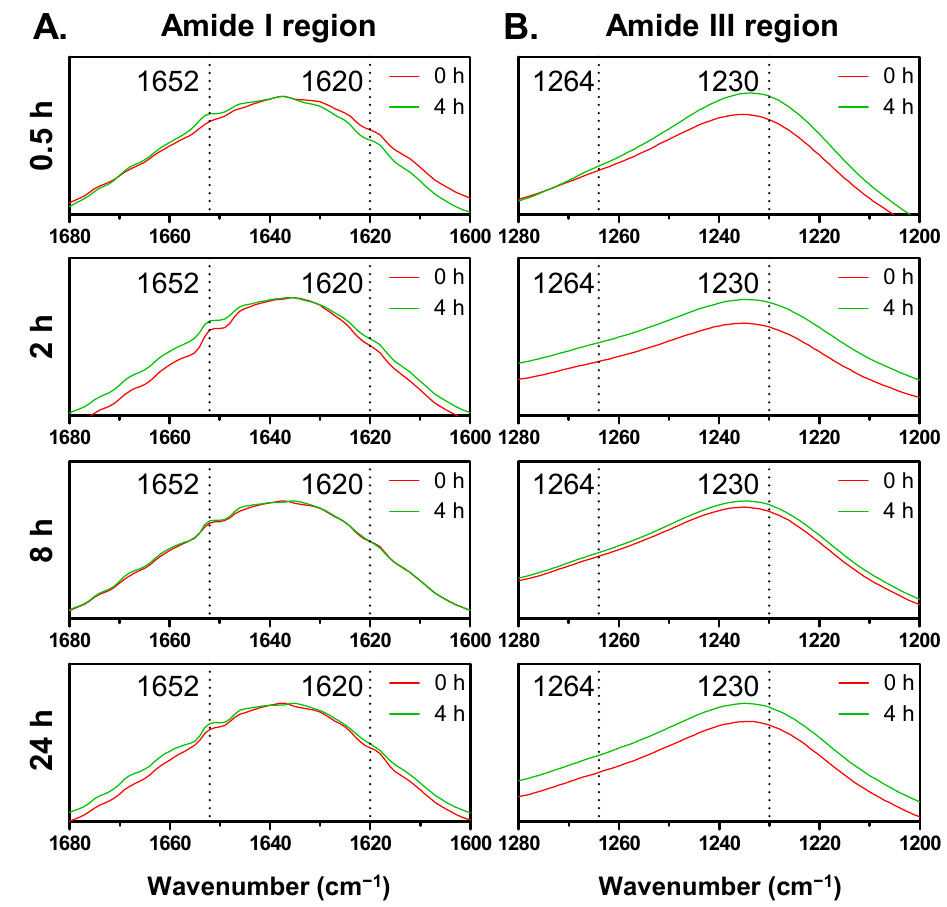
Figure 5. FT-IR spectra of SF films nonirradiated and irradiated with UV light for 4 h; ( A ) amide I region (1680–1600 cm − 1 ), ( B ) amide III region (1280–1200 cm − 1 ).